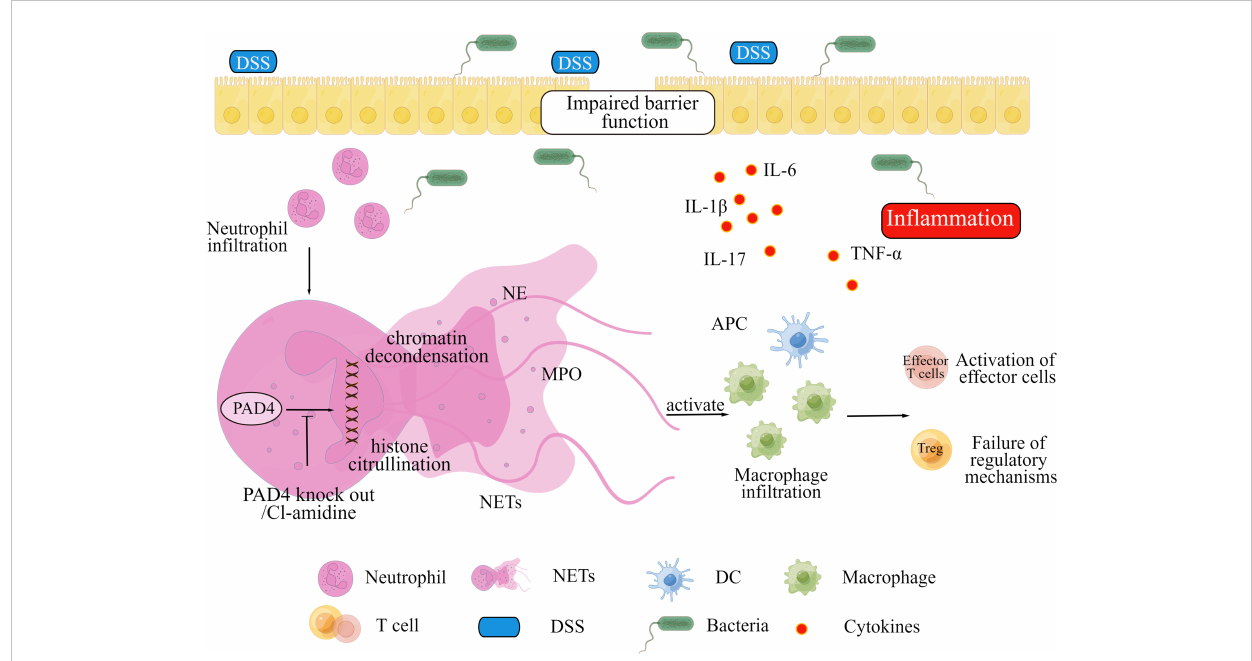
FIGURE 7 A proposed mechanism for PAD4-mediated NETs to mediate intestinal mucosal injury in DSS-induced